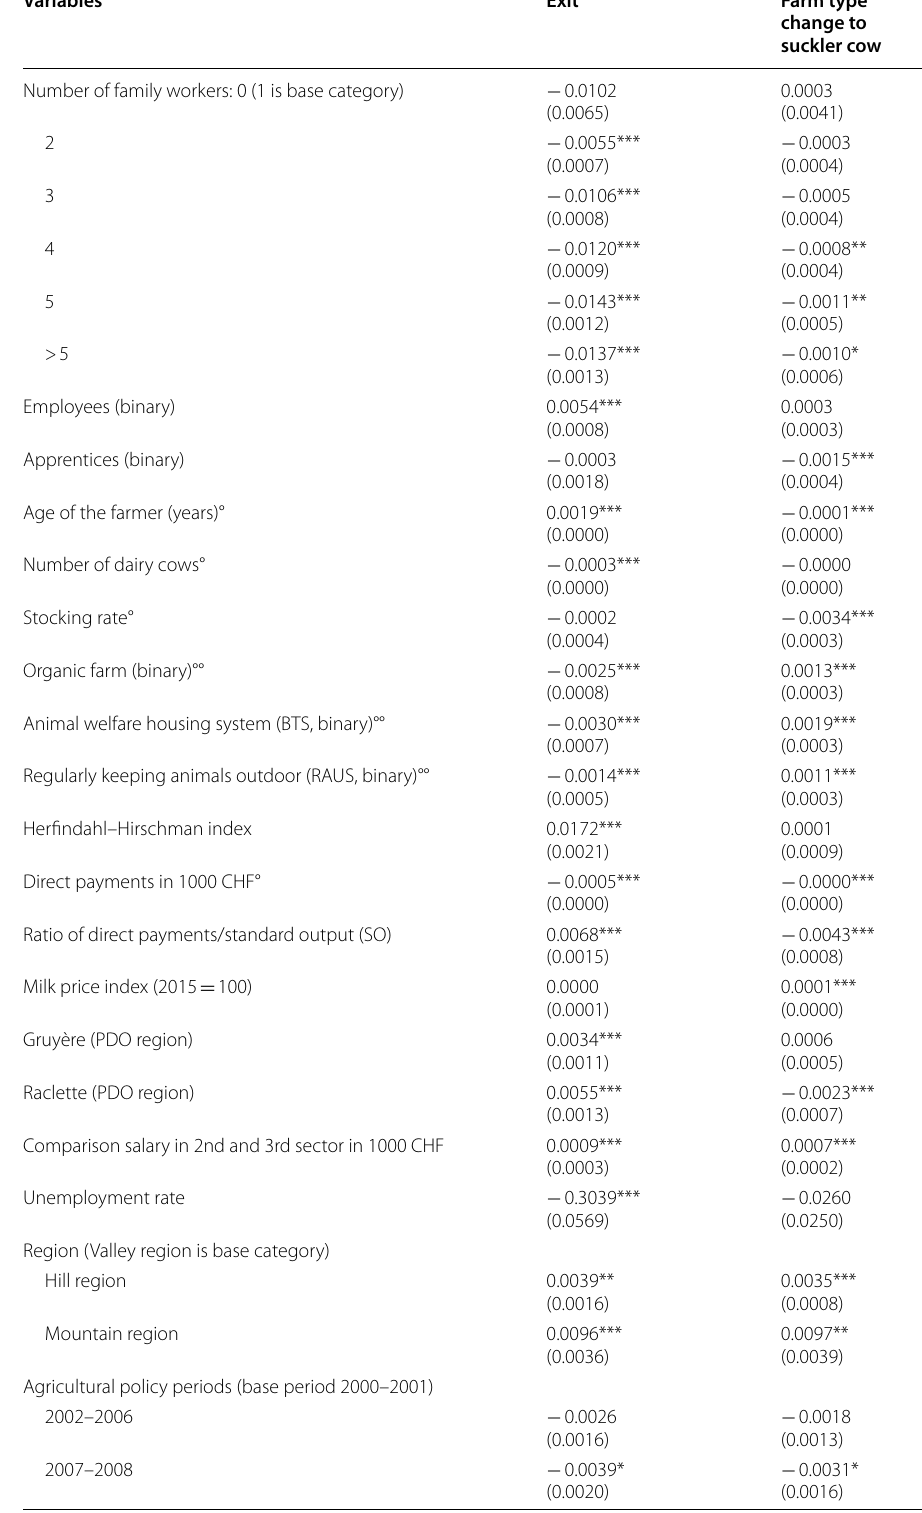
Table 7 Average marginal effects of logistic regressions. Source : Authors’ calculations based on AGIS 2000–2017, milk price data from the FSO and unemployment data from the SECO Variables Exit Farm type Number of family workers: 0 (1 is base category)